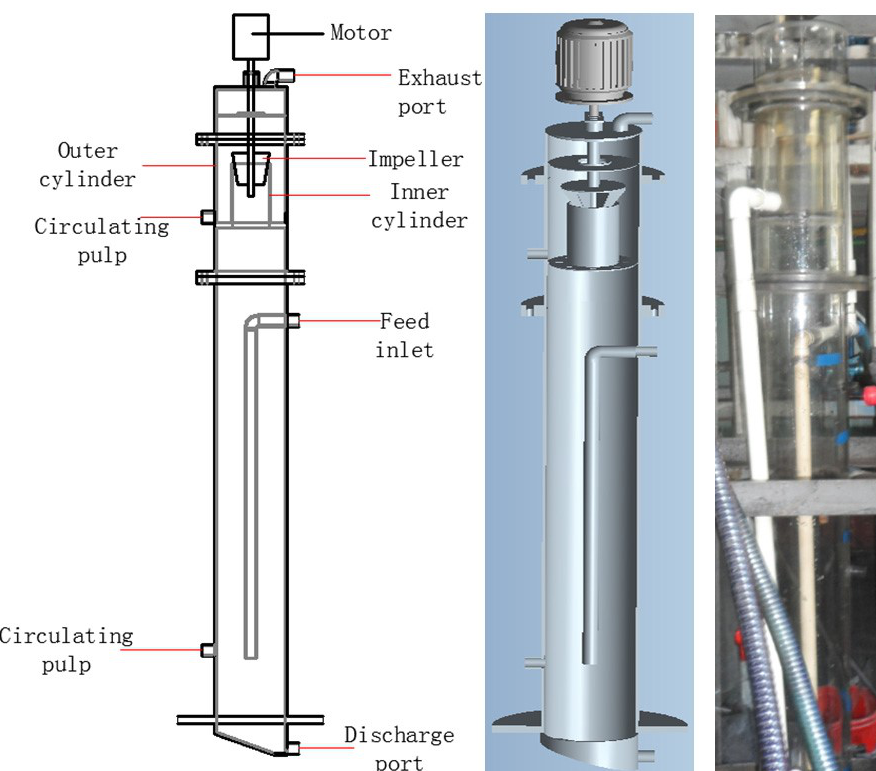
Figure 1. Schematic diagram of the vacuum mechanical defoamer